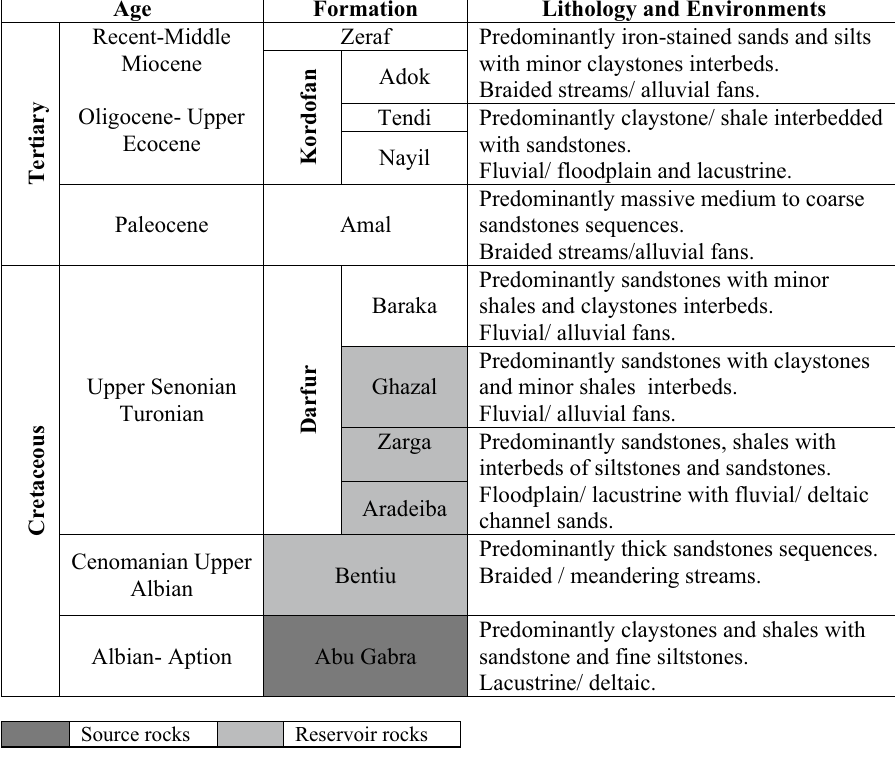
Table 1. Stratigraphic units of the Muglad rift basin, SW Sudan, their lithology and depositional environment (adapted from Schull 1988).